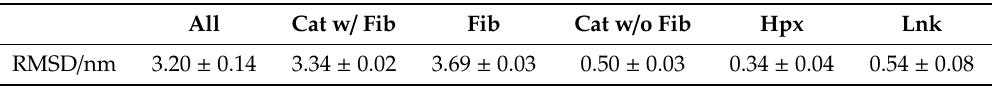
Table 2. Average root mean square deviation (RMSD) of the C α -trace of MMP-2 as a whole and divided into its individual domains: Cat, Fib, and Hpx with the Lnk region a,b